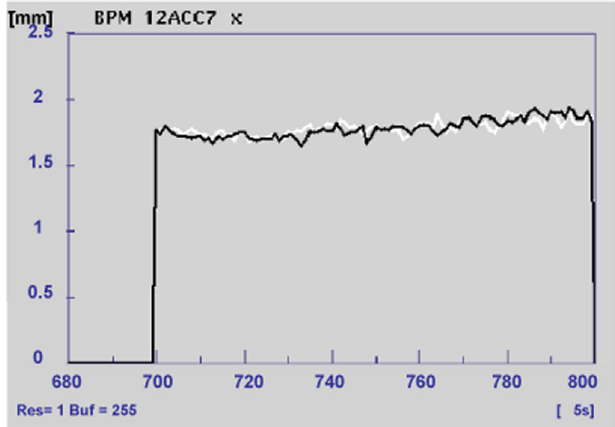
FIG. 13. (Color) Position of 100 bunches in a macropulse read by the reentrant BPM.